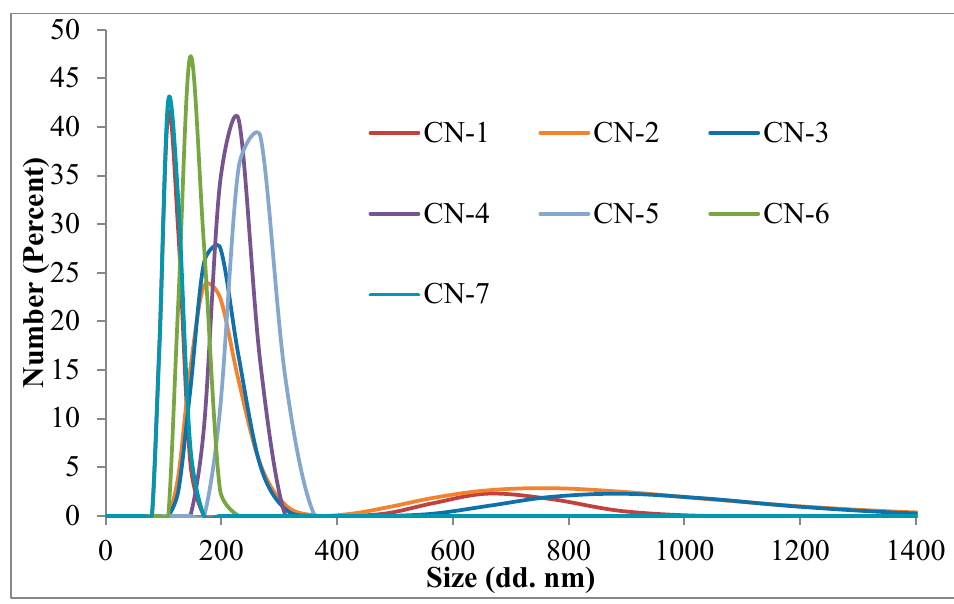
Figure 3. Size distribution curves of NCs in acetone at room temperature.